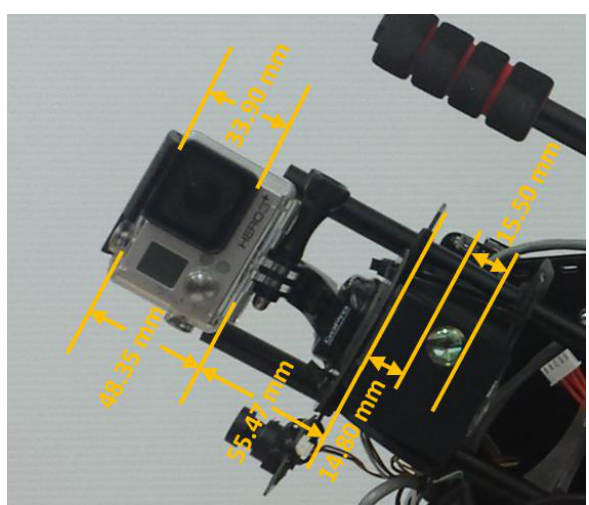
Figure 3. Detailed distance separation